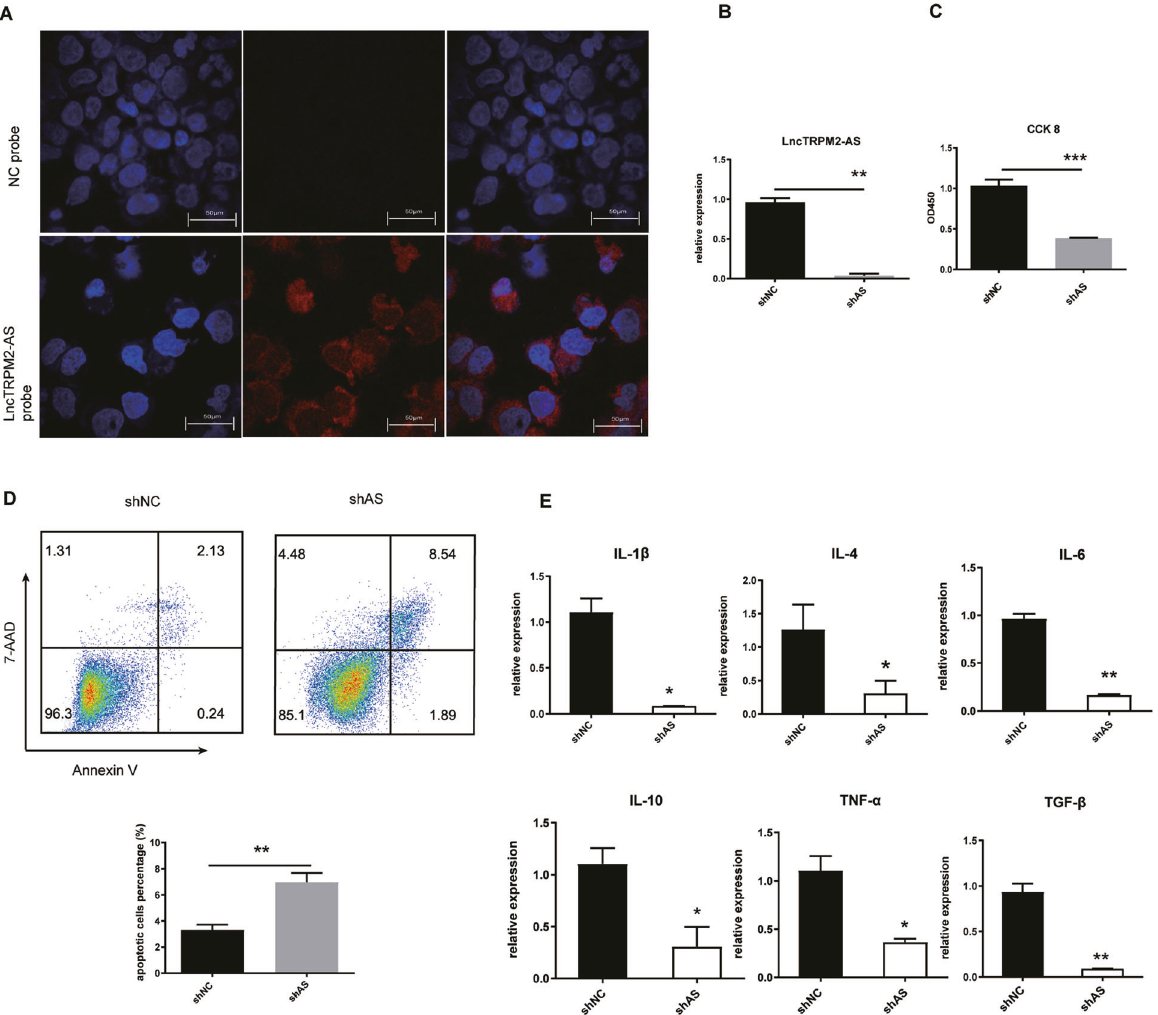
Fig. 2 LncTRPM2-AS silencing promotes THP-1 cell apoptosis and inhibits cytokine production. A THP-1 cells were labeled with a lncTRPM2-AS probe (red) and negative control (NC) probe (red) using fl uorescence in site hybridization (FISH), and counterstained with 4 ′ ,6- diamidino-2-phenylindole (DAPI) (nucleus staining, blue). B Con fi rmation of decreased lncTRPM2-AS levels following lncTRPM2-AS shRNA treatment. C Detection of cell proliferation in shNC or shlncTRPM2-AS (shAS) cells with the CCK-8 assay. D Detection of the apoptosis in shNC and shAS cells with the Annexin V/7-AAD assay. E Detection of the levels of IL-1 β , IL-4, IL-6, IL-10, TNF- α , and TGF- β in shNC and shAS cells by RT-PCR. Bars, ± SD; n = 3, * P < 0.05; ** P < 0.01; *** P <